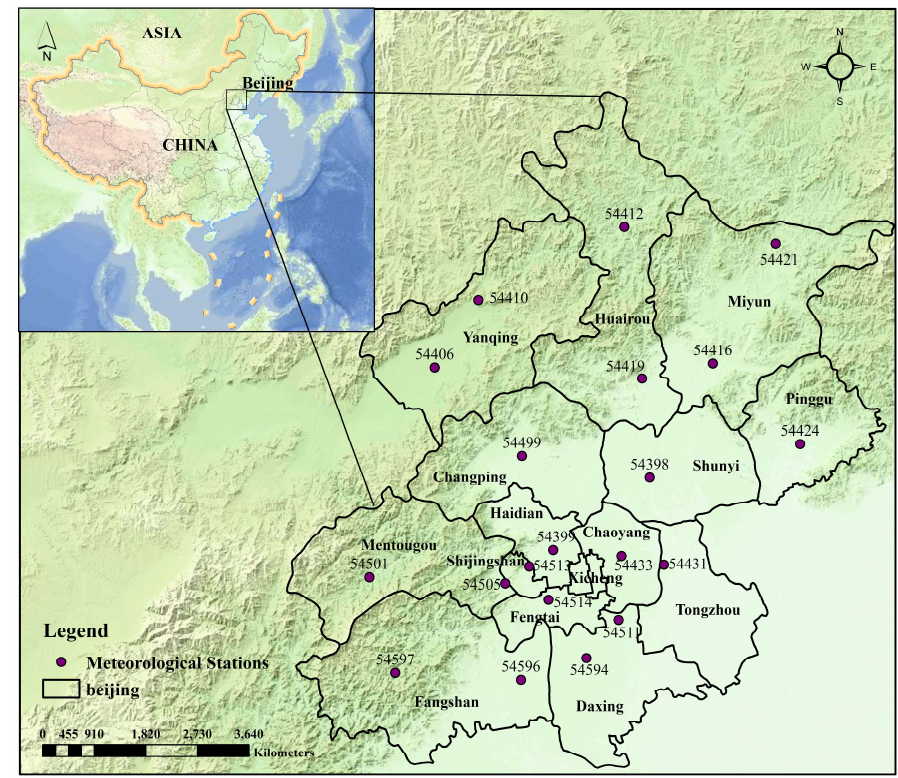
Figure 1. The Beijing study area showing the location of the 20 meteorological stations used herein. Table 1. Information on stations and their locations used in the study. Station Identity